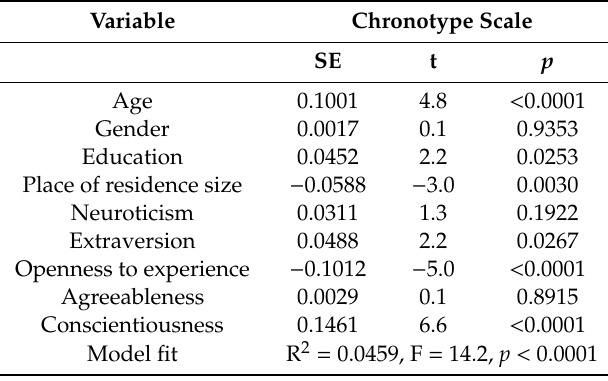
Table 5. Linear regression for chronotype score ( n =